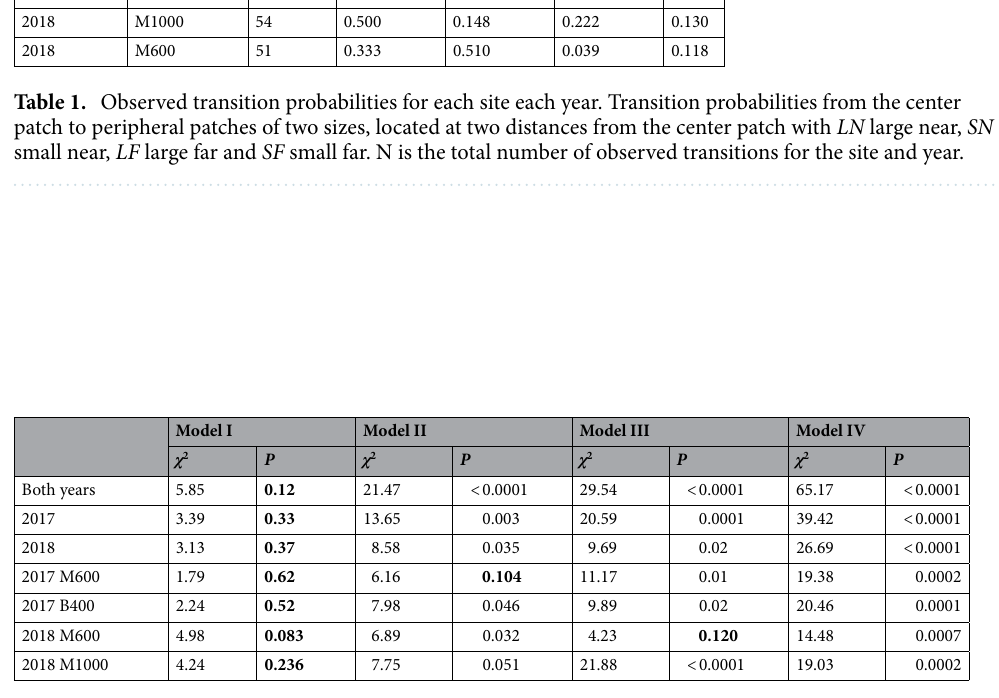
Table 2. Selection of the best model. Observed transition probabilities were compared against predicted values for each of the four models of patch attractiveness (defined in the text). The Chi-square value and associated probability, P value, are presented here. A model with a probability > 0.05 (bolded) indicates a good fit to the empirical